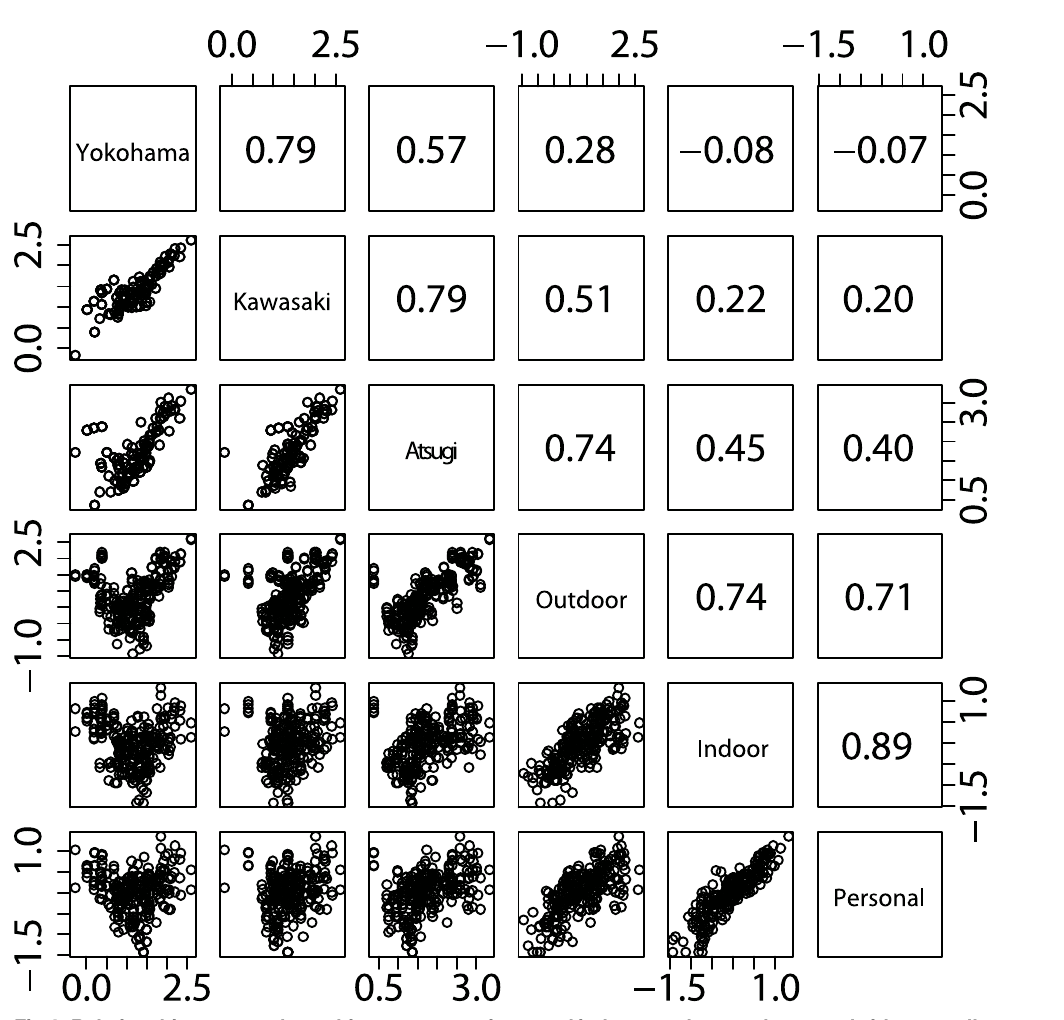
Fig 4. Relationships among the ambient concentrations, and indoor, outdoor, and personal airborne pollen counts. Ambient pollen concentrations monitored at the Yokohama, Kawasaki, and Atsugi stations are reported in the base 10 logarithm of pollens m -3 . Outdoor, indoor, and personal pollen counts measured for each subject in Isehara are reported in the base 10 logarithm of pollens cm -2 day -1 . Each data point represents measurements for each sampling period. Measurements for all subjects are included for the outdoor, indoor, and personal pollen count data. The values in the upper panels indicate the Pearson product-moment correlation coefficients based on the log-transformed pollen concentrations or